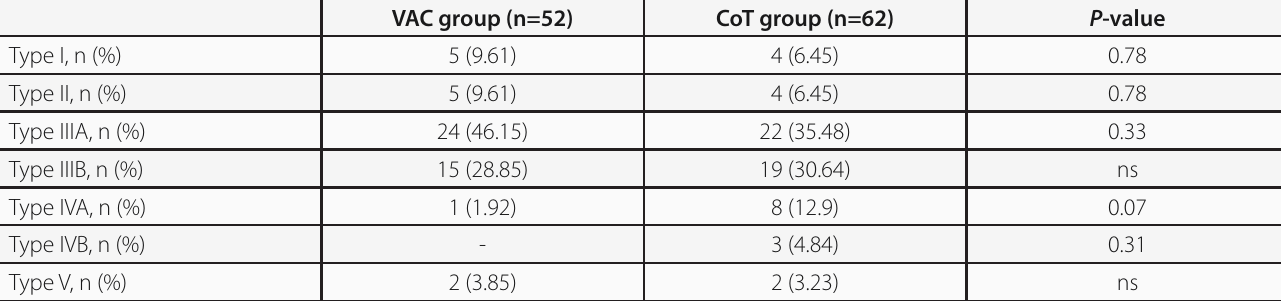
Table 5. Post-sternotomy mediastinitis according to El Oakley classification